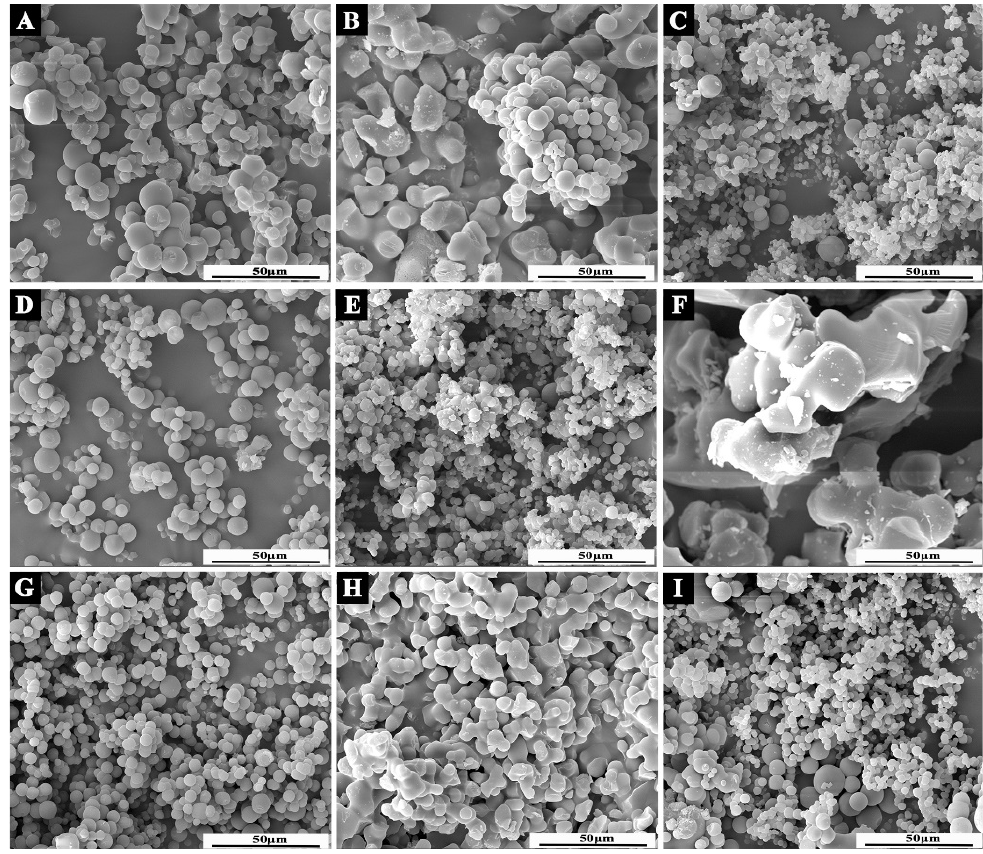
Figure 3. SEM of the microcapsules under orthogonal test parameters: ( A ) sample #1; ( B ) sample #2; ( C ) sample #3; ( D ) sample #4; ( E ) sample #5; ( F ) sample #6; ( G ) sample #7; ( H ) sample #8; ( I ) sample #9.